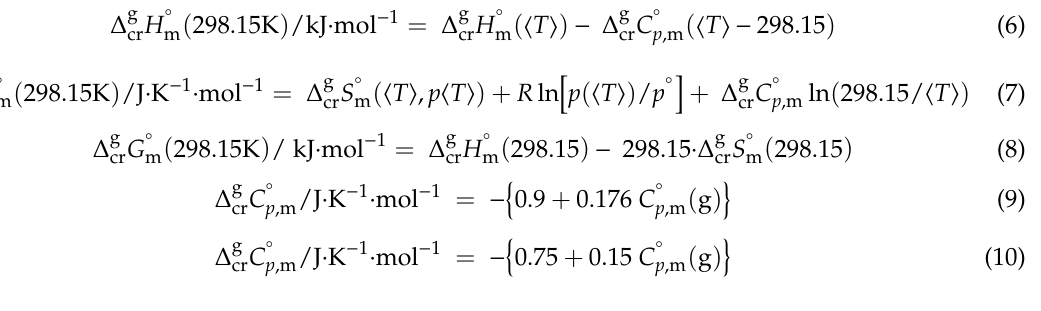
◦ = 0.1 MPa) molar enthalpies, ∆ g cr H